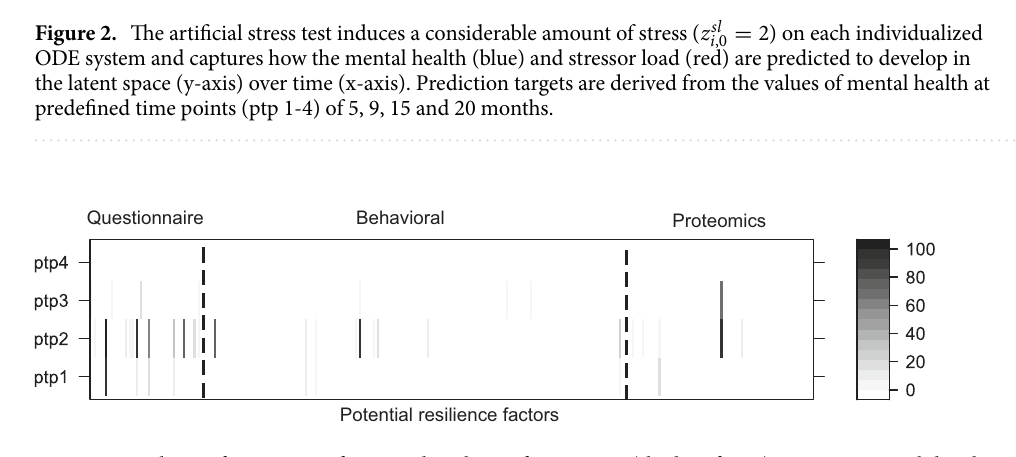
Figure 3. Inclusion frequencies of potential resilience factors in % (shades of gray) using a cross-validated lasso analysis ( n = 88 ; p = 350 ; 1000 repetitions) predicting mental health at predefined time points (ptp) of the artificial stress test, i.e., the intersection of the blue lines with the vertical, dotted lines in Fig. 2). We identified potential resilience factors in all three data modalities (i.e., questionnaires, behavioral measures, and